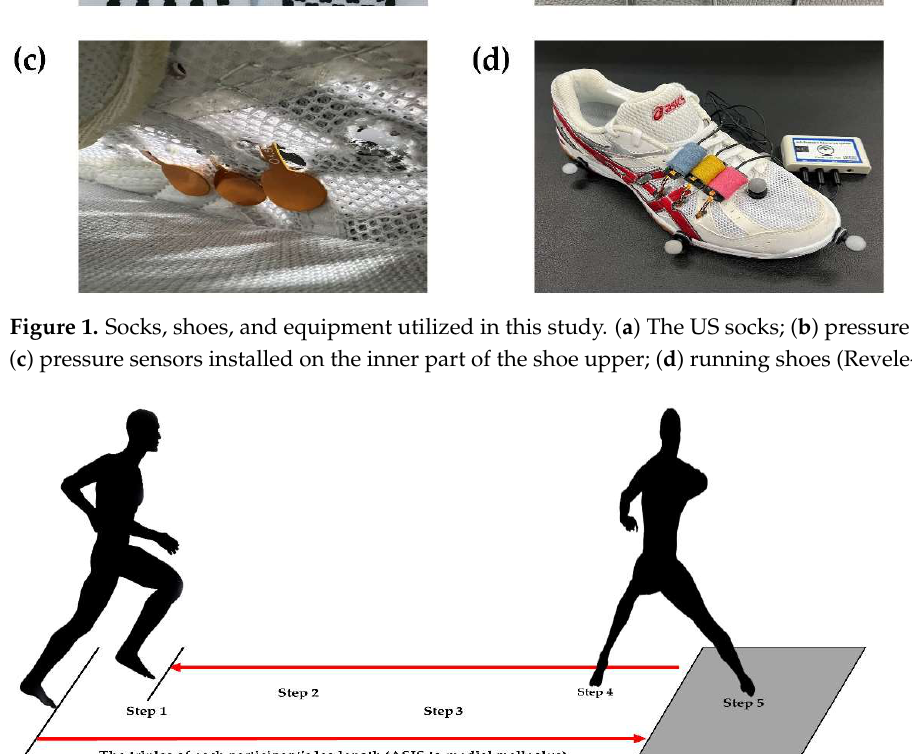
Figure 1. Socks, shoes, and equipment utilized in this study. ( a ) The US socks; ( b ) pressure sensors; ( c ) pressure sensors installed on the inner part of the shoe upper; ( d ) running shoes (Revele-FL5).